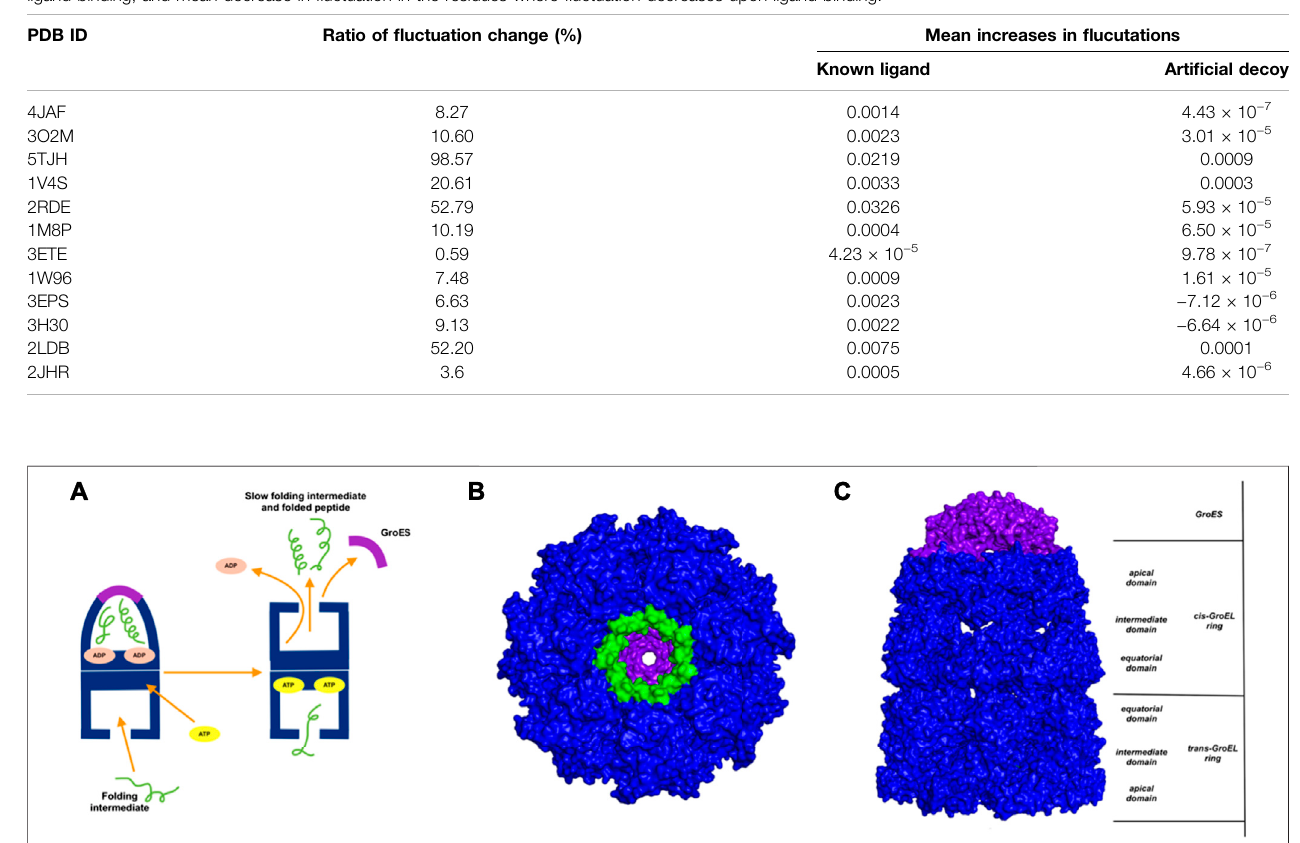
FIGURE 4 | Release of peptide ligand from GroEL-GroES Complex. (A) Mechanism of GroEL-GroES cis-ring uncapping is likely mediated by trans-ring peptide binding. GroEL is shown in blue and GroES in purple and peptide in green. (B) The bottom GroES trans-ring binds with peptide. (C) Perpendicular view of GroEL-Groel